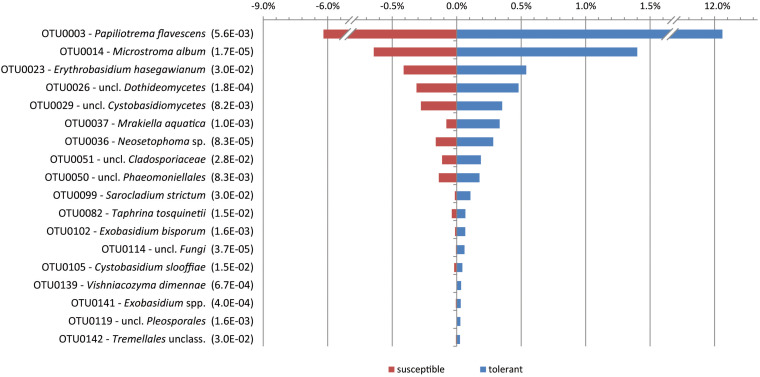
Significantly increased OTUs in tolerant ashes. The OTUs are sorted according to their relative abundance (>0.02), and the level of significance (FDR) is given in brackets.